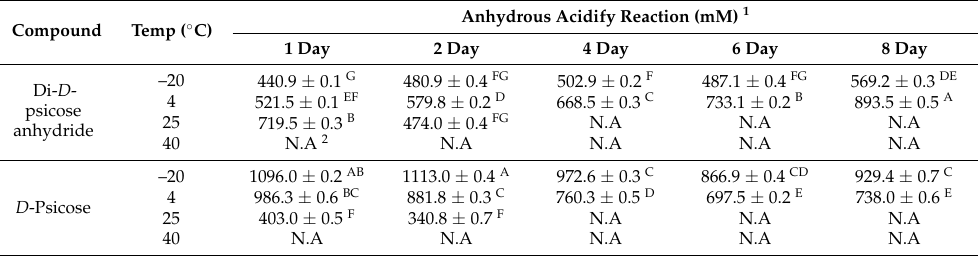
Table 1. Effects of reaction time and temperature on di- D -psicose anhydride (DPA) and D -psicose concentrations.